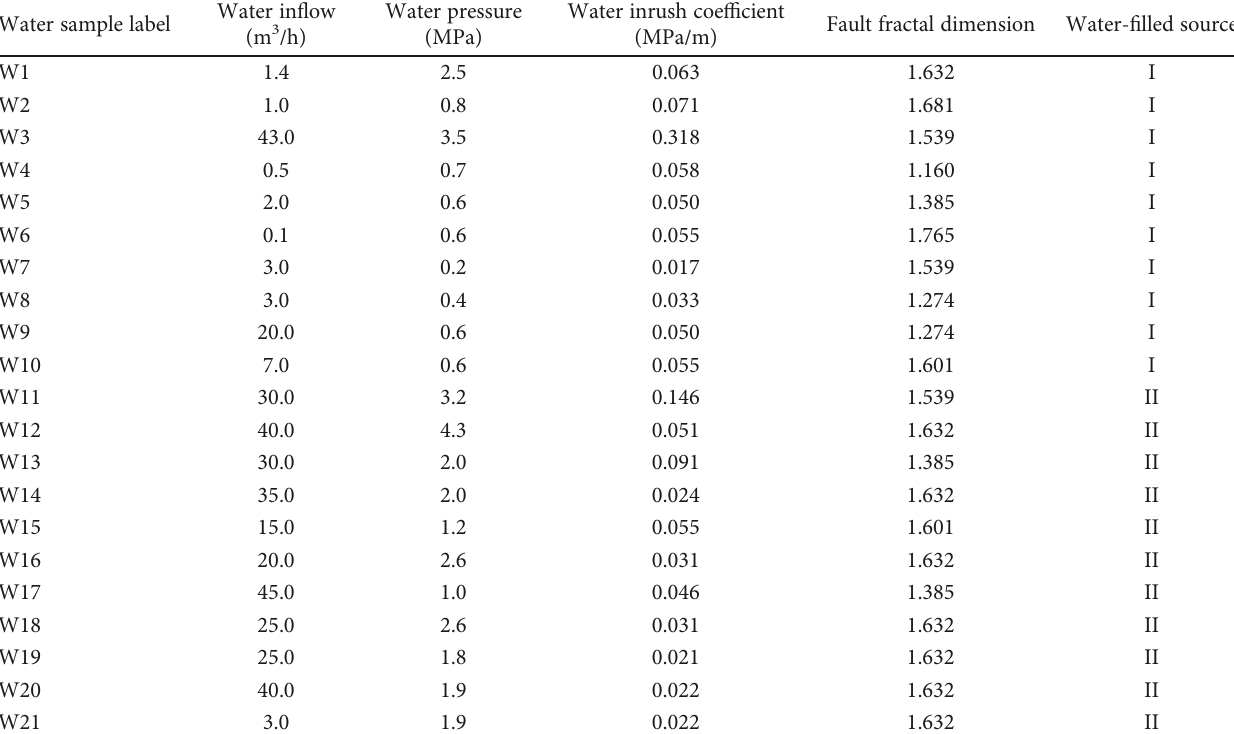
Table 2: Discriminant index of water inrush water source.